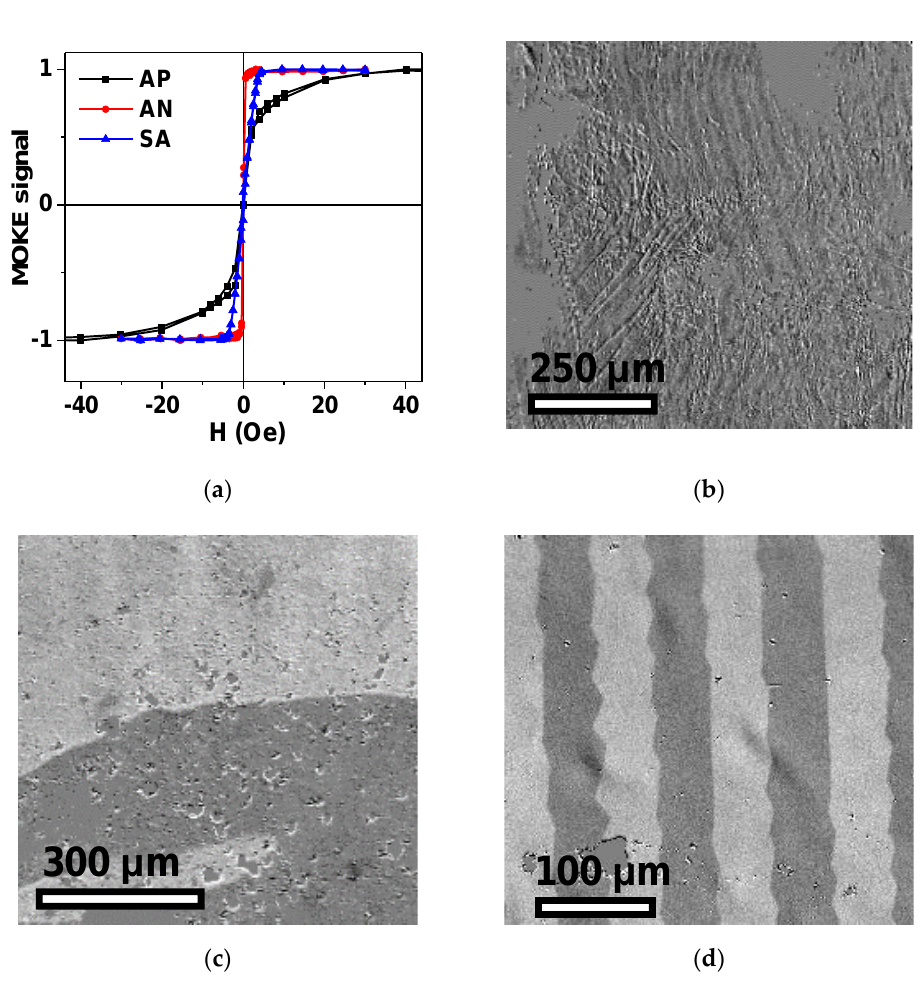
Figure 5. MOKE hysteresis loops for amorphous Fe 3 Co 67 Cr 3 Si 15 B 12 ribbons in AP, AN and SA states measured for the external magnetic field applied in the plane of the ribbon and along the long side of the ribbon ( a ). Magnetic domain structure for amorphous Fe 3 Co 67 Cr 3 Si 15 B 12 ribbons in states: AP ( b ), AN ( c ) and SA ( d ). External magnetic field is equal to zero. Ribbon´s long side is oriented in horizontal direction for all images.